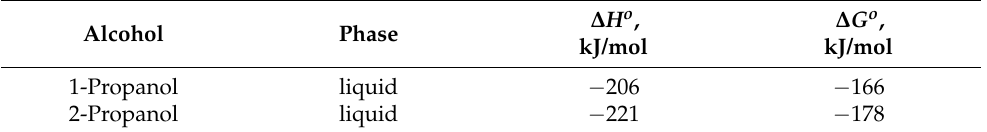
Table 1. The values of the standard enthalpy ( ∆ H o ) and Gibbs free energy ( ∆ G o ) for 1-Propanol (1-Pr) and 2-Propanol (2-Pr) formation during glycerol hydrogenolysis.